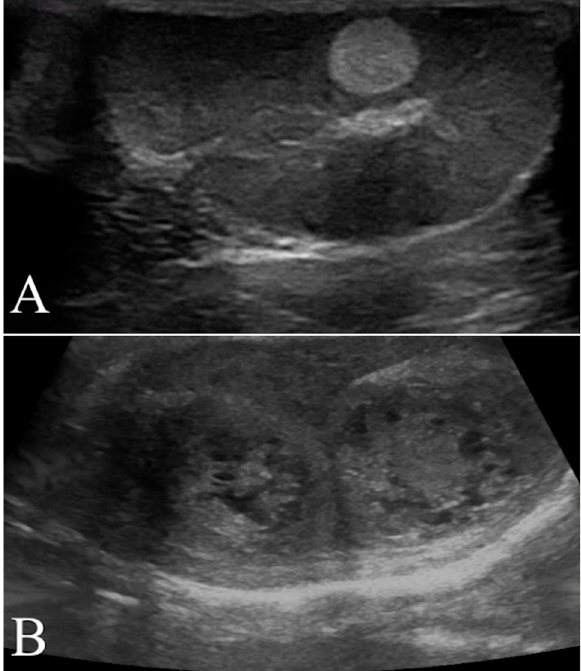
Figure 1. Representative B-Mode ultrasonography scans. ( A ) Left testis of a 11 year old mixed breed dog with a focal hyperechoic nodule (seminoma) characterized by homogenous echotexture and regular margin. ( B ) Mixed cell tumor (leydig and seminoma) recorded as two nodular lesions in the right testis of a 13 year old Epagneul Breton. The lesions had mixed patterns, inhomogeneous echotextures and irregular margins.